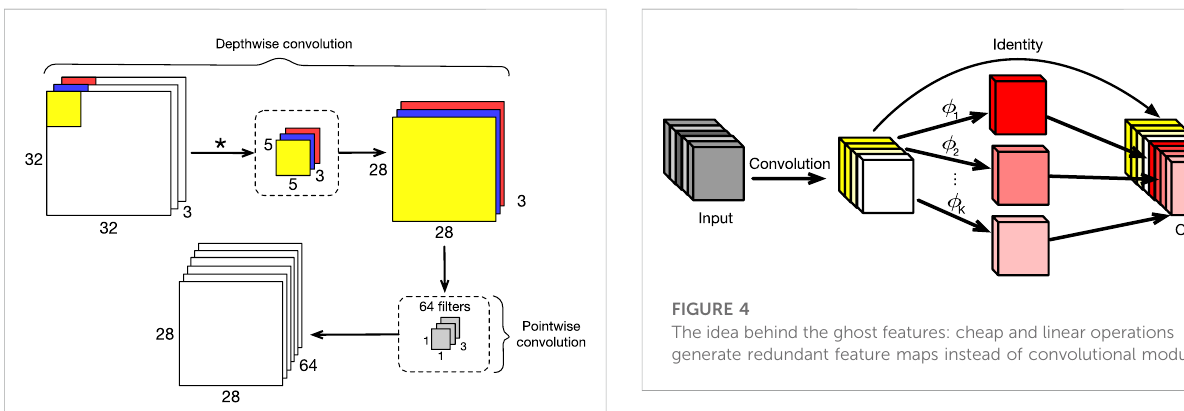
FIGURE 2 The input 32 × 32 × 3 image is convolved with a 5 × 5 × 3 kernel, ending up in a 28 × 28 × 3 output (76,800 multiplication operations). Further,thefeaturemapsareconvolved with64 fi ltersofsize 1×1× 3, endingupin150,528multiplicationoperations,summing76,800 + 150, 528 = 227, 328 operations.